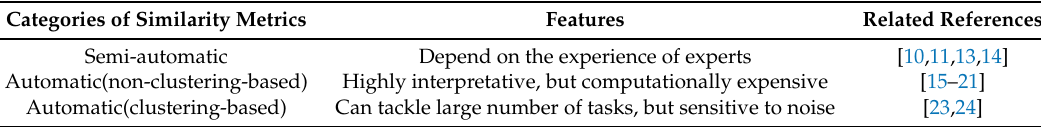
Table 1. Classification of similarity